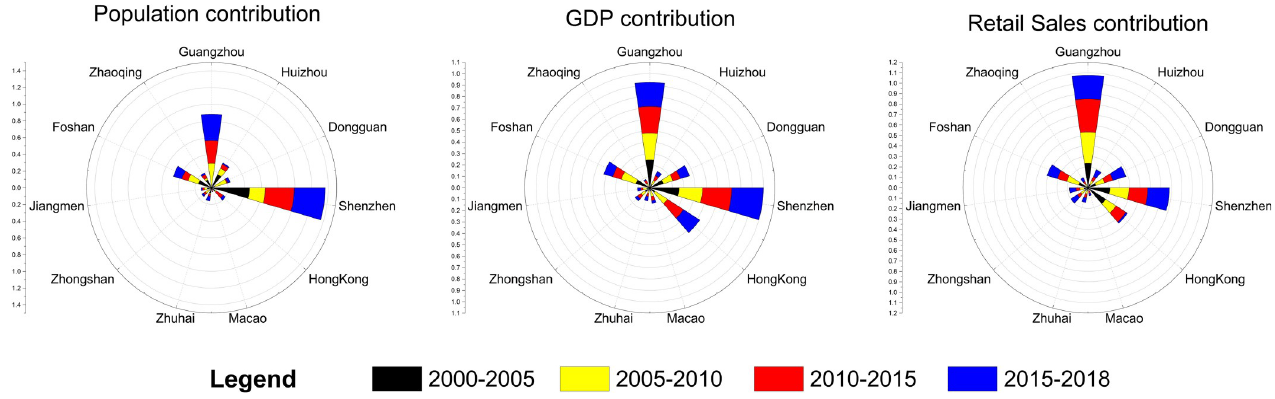
Fig 10. The contribution of each city to the movements of the gravity